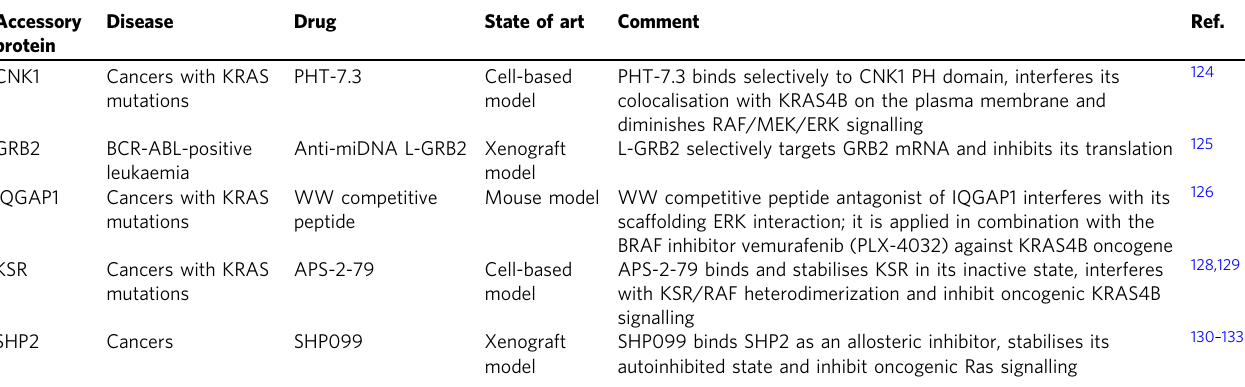
Table 1 Accessory proteins as attractive therapeutic